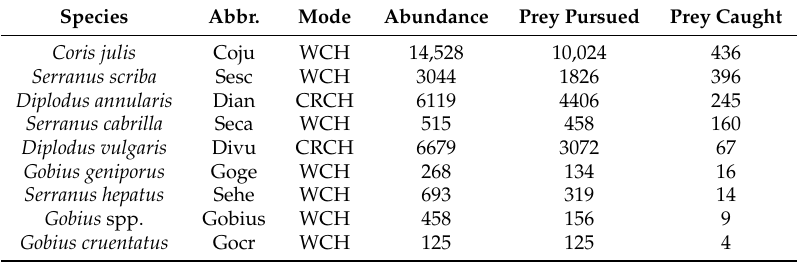
Table 3. Species exhibiting the most aggressive predatory behavior, as defined by observed proportion success in ingesting the lure. Mode: Predation mode (refer to Table 1). Abundance: total number of individuals recorded. Prey pursued/caught: total number of times the predatory species was observed pursuing/partially to wholly ingesting the